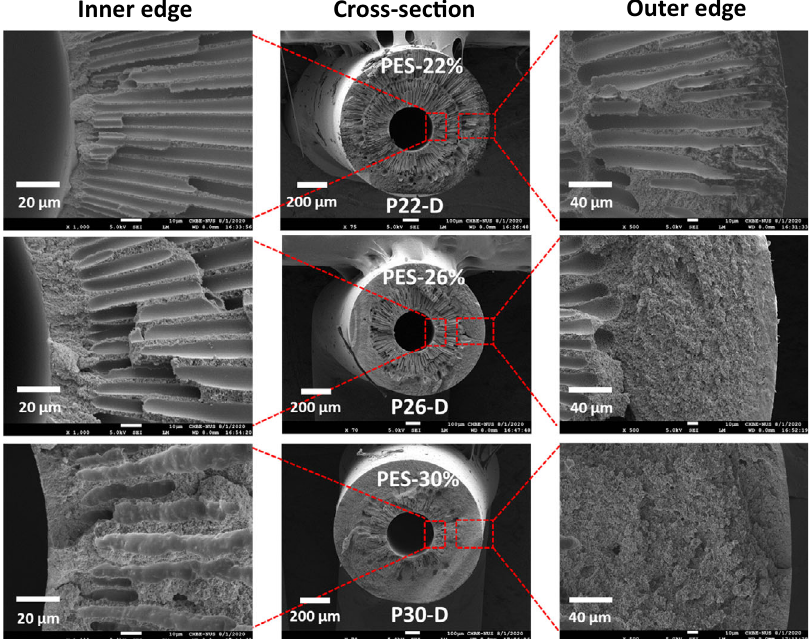
Fig. 3 Highlighted FESEM morphologies of representative PES hollow fi ber substrates. The hollow fi bers were spun at the dope to bore fl uid ratio of